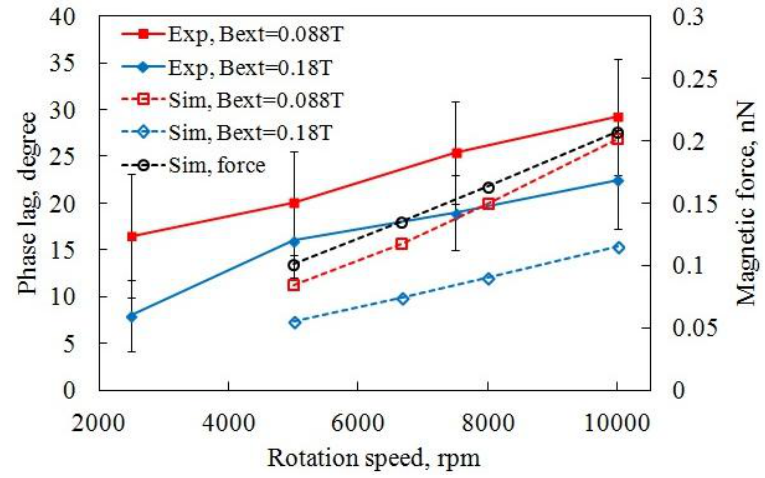
Figure 8. Experimental and simulated (use the model described previously) phase angle lags for four different magnetic field rotational speed and two different magnetic field strengths. The force plotted here is the horizontal component of the magnetic force which is balanced by the viscous drag force. Each experimental data point represents 60 measurements across 6 time points. Error bars represent one standard